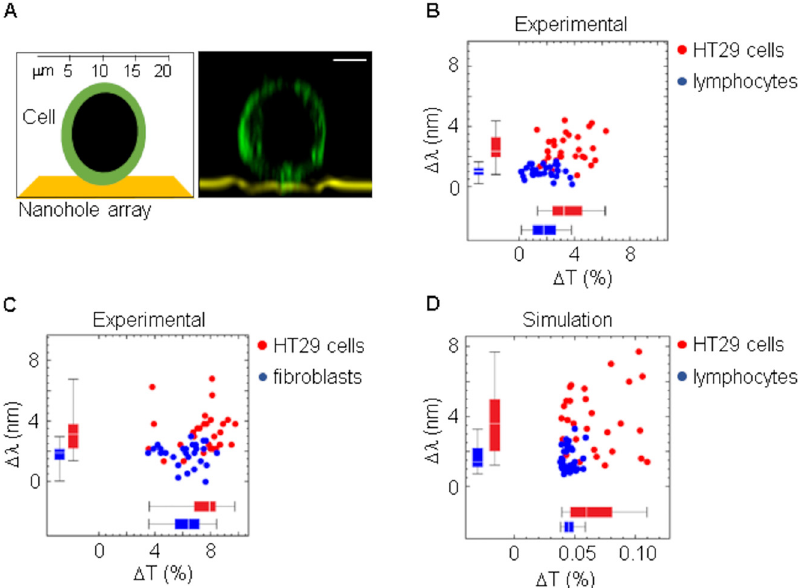
Figure 5: Differences in spectral shift and transmittance between HT29 colorectal cancer cells and normal primary cells. (A) Transversal confocal microscopy of a live HT29 cell on a nanohole array and a schematic representation of the image. Scale bar: 5 μ m. (B) SpectraldifferencesbetweenHT29cellsandPBMCs.Thresholdwassetto2.2nmandsensitivity(87%)andspeci fi city(97%)weredetermined. (C)SpectraldifferencesbetweenHT29cellsandepidermal fi broblasts.Thresholdwassetto2.2nmandsensitivity(73%)andspeci fi city(78%) weredetermined.(D)ComputersimulationcomparingHT29cancercellswithnormalcells(PBMCs).Thresholdwassetto2.7nmandsensitivity (90%) and speci fi city (75%) were determined.